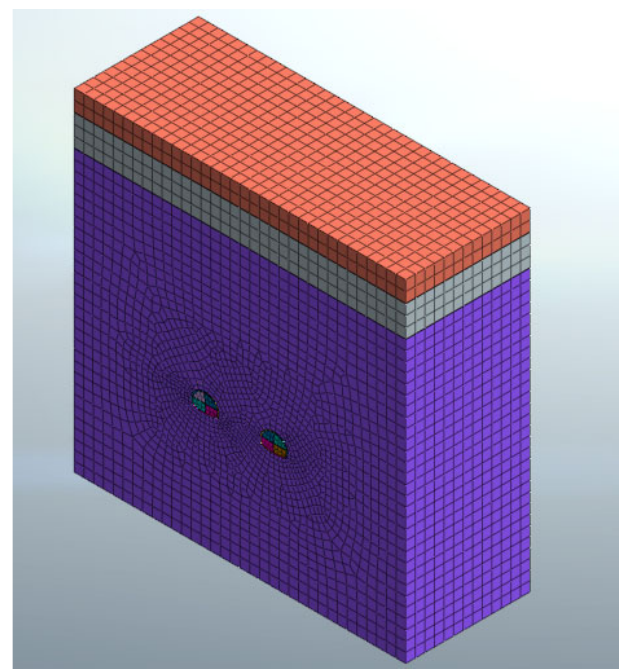
Figure 4. Separate tunnel model.